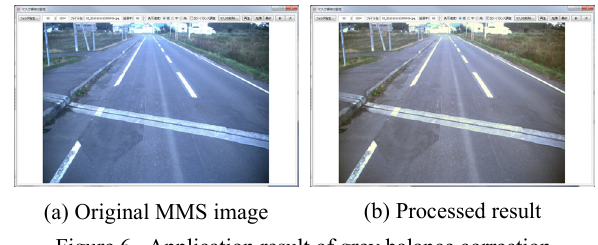
Figure 6. Application result of grey balance correction